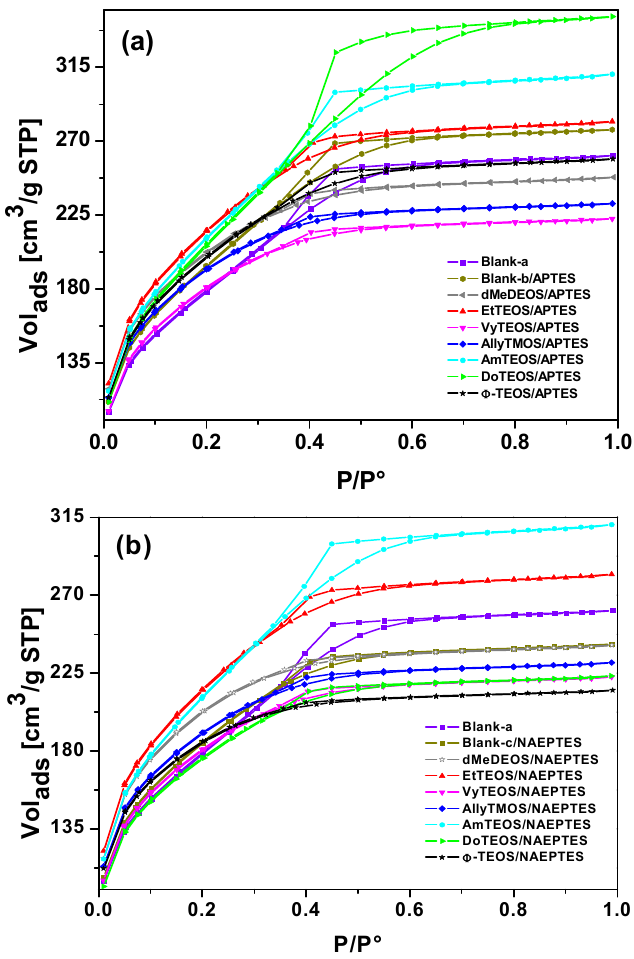
Figure A1. N sorption-desorption isotherms at 76K of organo-modified silica pore 2 networks including H T( p- COOH)PP species bonded to the walls through the use of 2 APTES ( a ) or NAEPTES ( b